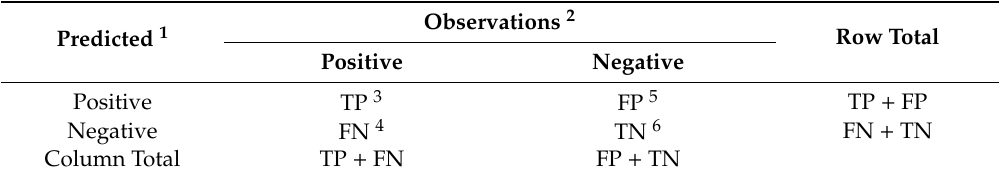
Table 2. Cross-tabulation matrix.